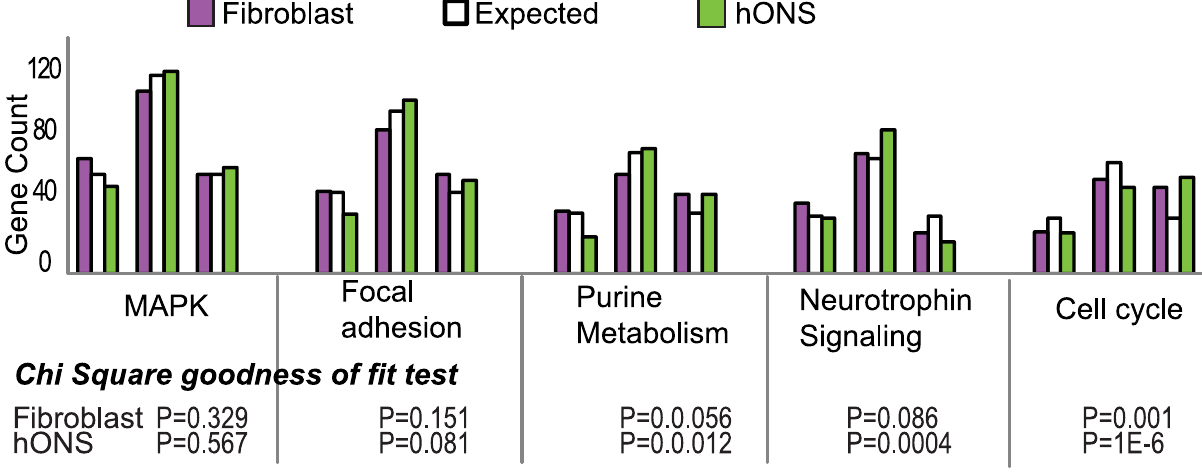
Figure 3. Distribution of variance patterns in the top 5 attract pathways for hONS and fibroblast cells. Chi-square goodness of fit was used to determine if variance profiles differed significantly from the expected 25:50:25% patterns.